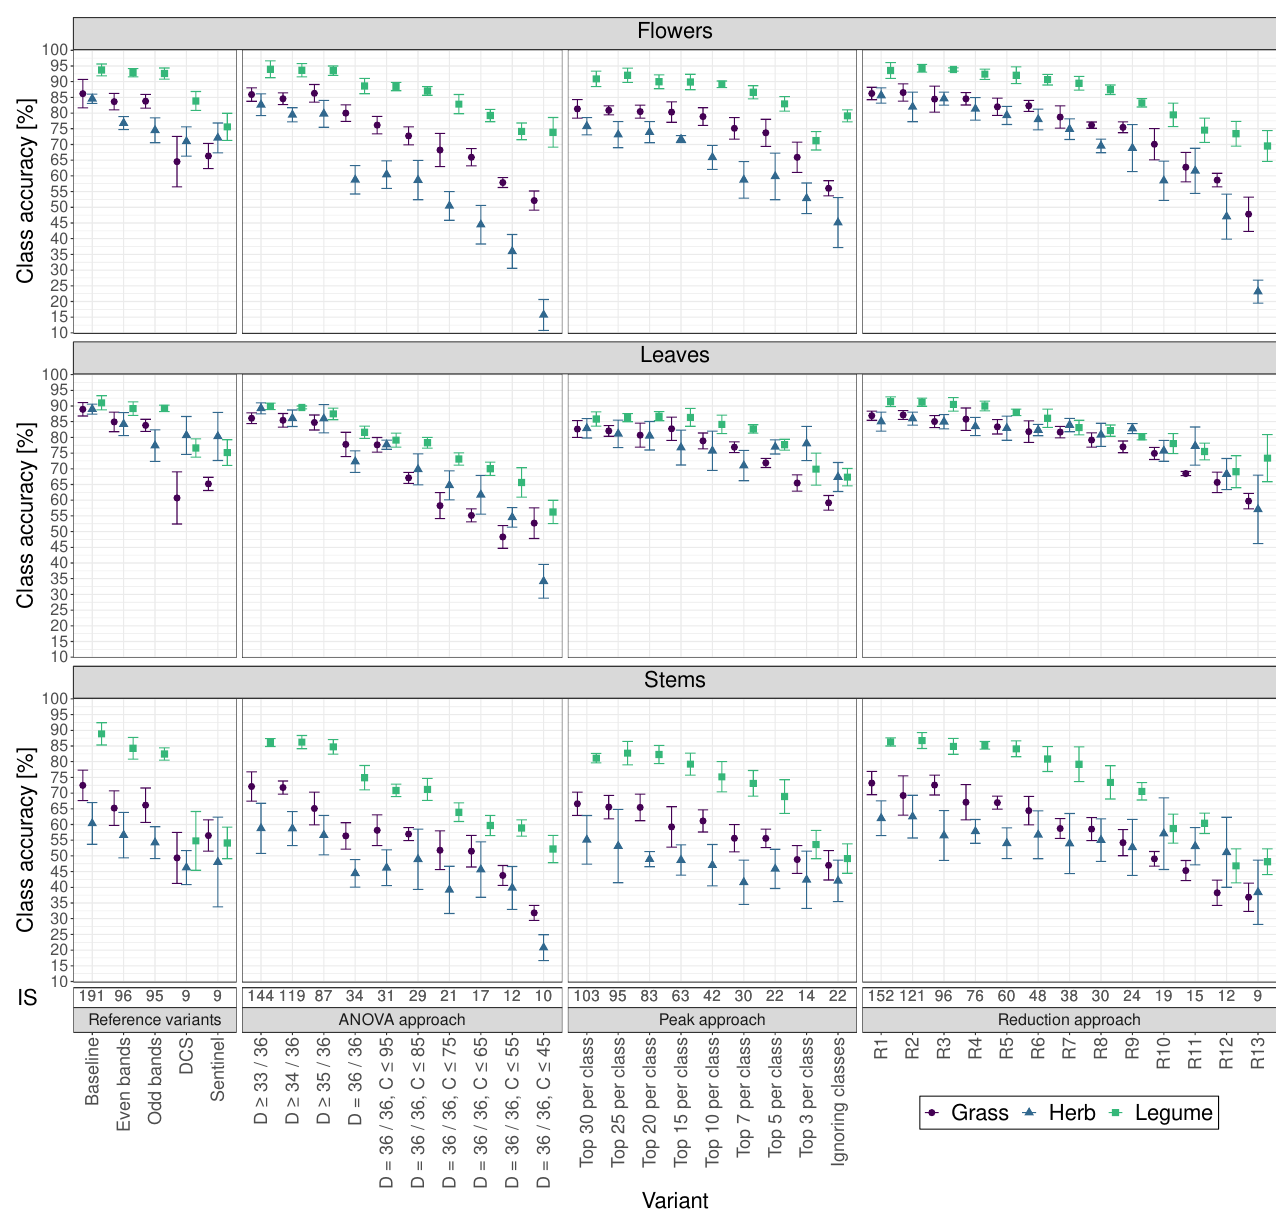
Figure 4. Mean classification accuracy based on plant parts for different species groups in different approaches. IS denotes the input size. Measures are shown with a slight x -axis offset for better visualization. Error bars indicate standard deviation, five-fold